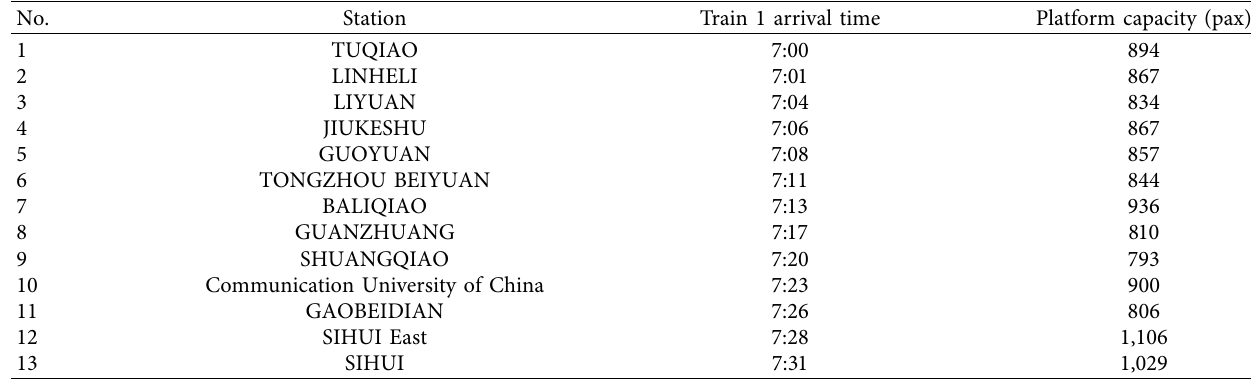
Table 12: The first train’s arrival time and the platform capacity at each station.